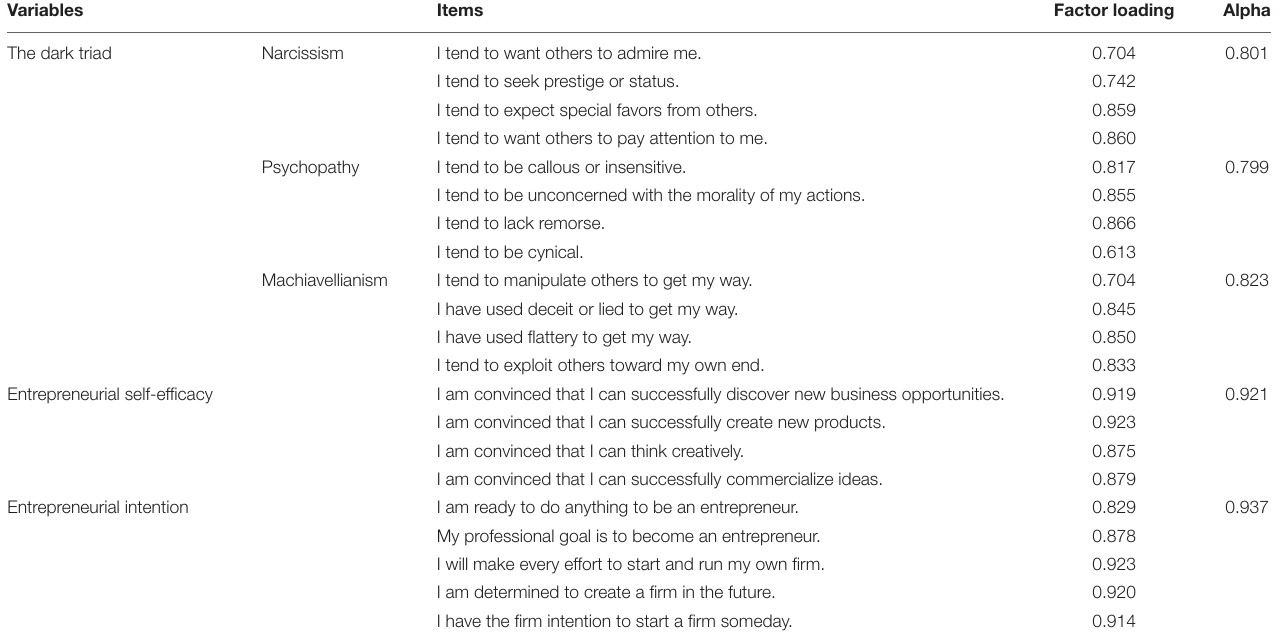
TABLE 1 | Measurement items and reliabilities.